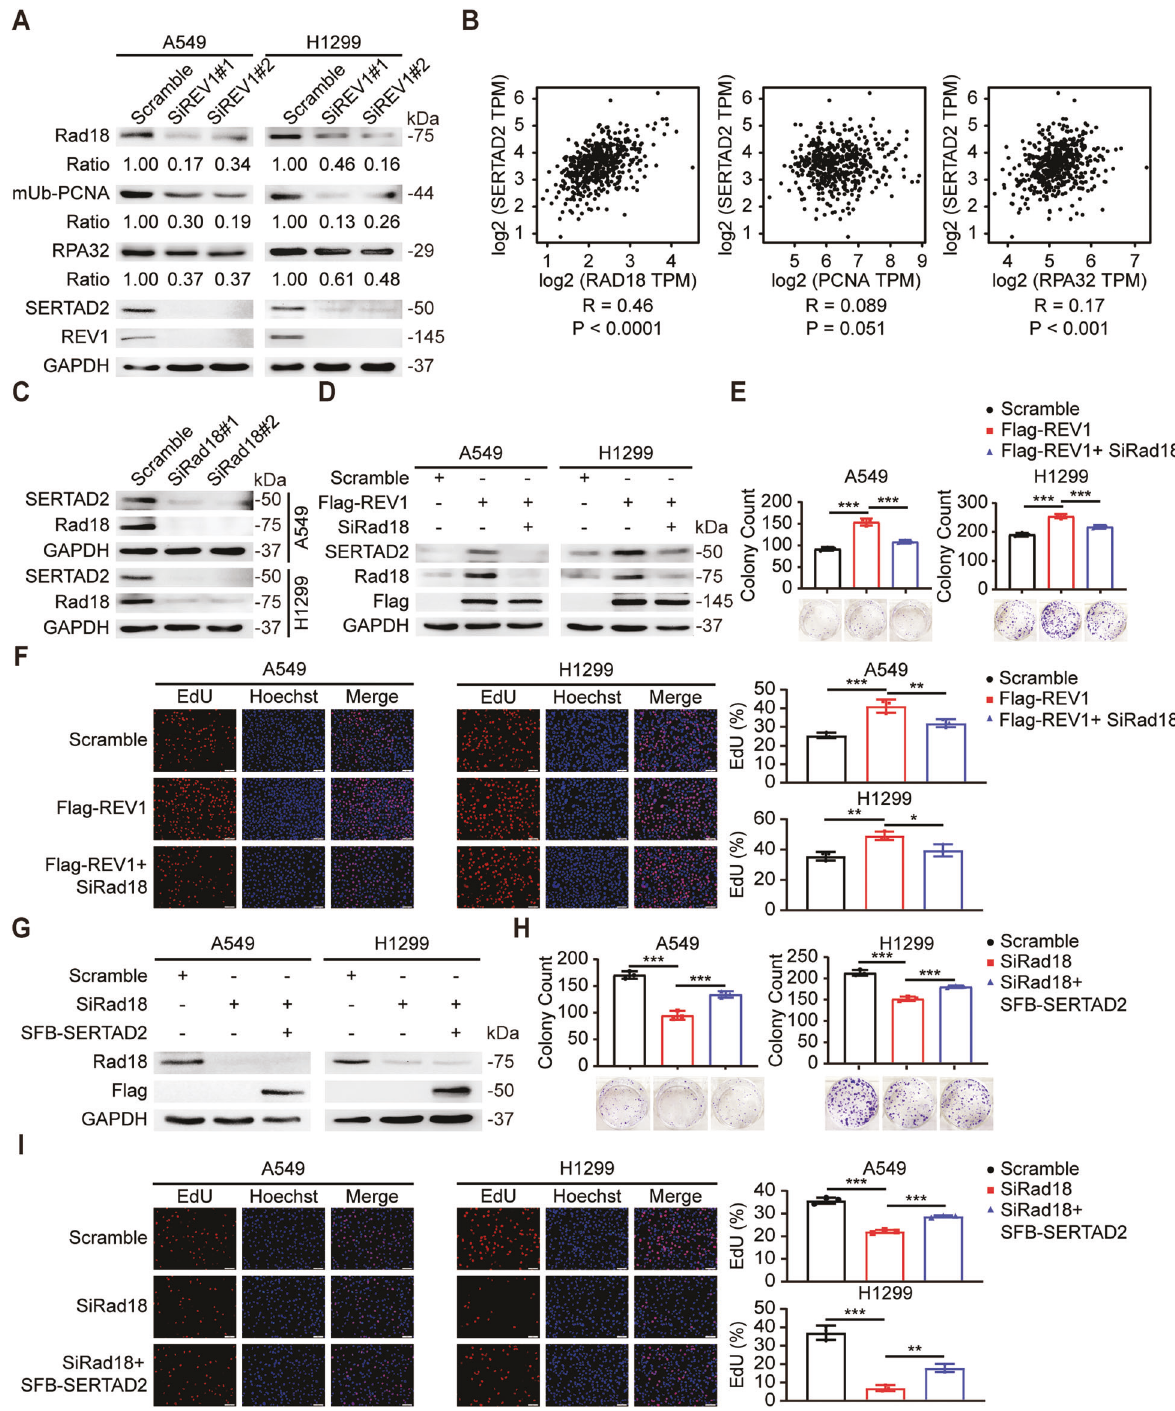
Fig. 6 The regulatory effect of REV1 on SERTAD2 is partially dependent on Rad18. A Proteins from REV1-silenced A549 and H1299 cells were harvested and examined by Western blot ( n = 3). B Scatter plots of SERTAD2 expression vs. Rad18, PCNA, and RPA32 expression in lung adenocarcinoma samples acquired from the GEPIA database. C The protein level of SERTAD2 was decreased in Rad18-depleted cells ( n = 3). D A549 and H1299 cells transfected with SiRad18 and Flag-REV1 were harvested and examined by Western blot ( n = 3). E Cells transfected with SiRad18 and Flag-REV1 were harvested for colony formation assays. Representative pictures of the indicated groups and quantitative analysis of the colony counts are shown. *** P < 0.001 ( n = 3). F EdU incorporation assays were used to test the proliferation of cells transfected with SiRad18 and Flag-REV1. Representative pictures of the indicated groups and statistical analysis results are presented. * P < 0.05, ** P < 0.01, *** P < 0.001 ( n = 3). Scale bar: 50 μ m. G – I A549 and H1299 cells transfected with SiRad18 and SFB-SERTAD2 were harvested for cell proliferation assays. Representative pictures of the indicated groups and the statistical analysis results are shown. ** P < 0.01, *** P < 0.001 ( n = 3). Scale bar: 50 μ